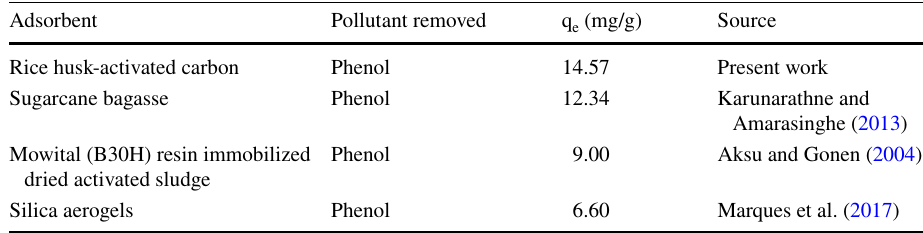
maximum equilibrium adsorption capacity for different adsorbents